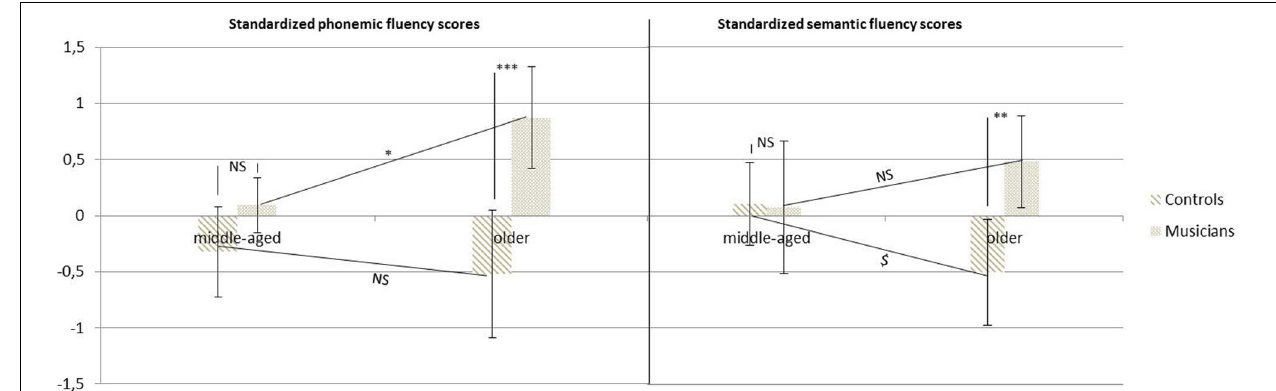
FIGURE 2 | Phonemic and semantic fluency z scores as a function of age for middle-aged and older musicians and controls ( $ p < 0 . 1; ∗ p < 0 . 05; ∗∗ p < 0 . 01; ∗∗∗ p < 0 . 001).